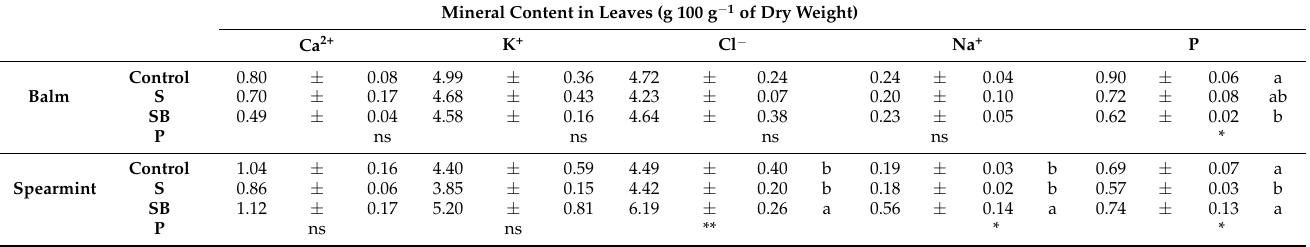
Table 1. Leaf mineral content of balm and spearmint plants at 15th day. Values are mean ± S.E. of six